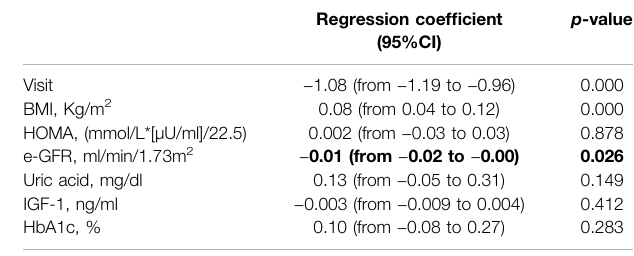
TABLE 4 | Multivariate linear mixed models of LVEDV/BSA over time.